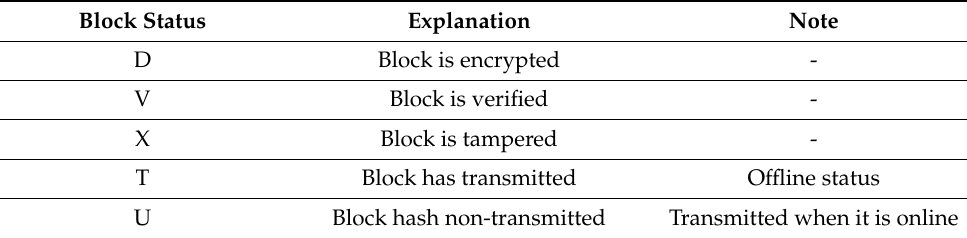
Table 5. Block Status Flag.